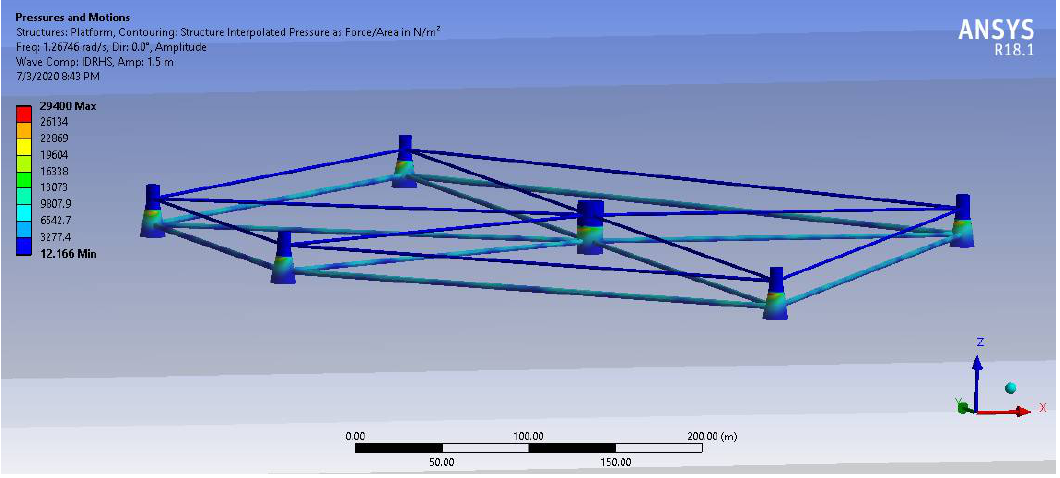
Figure 18. Pressure distribution on the floating platform.